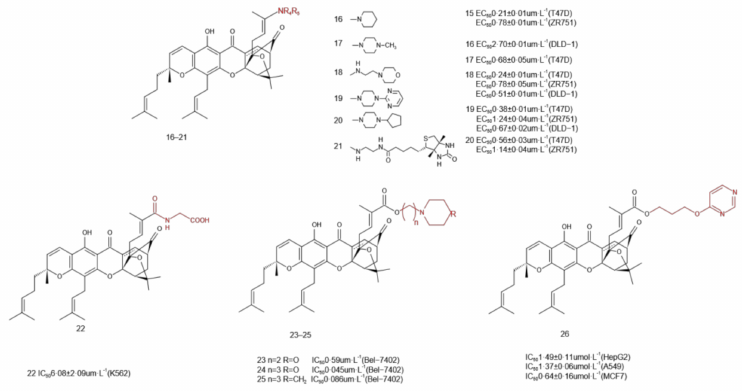
Figure 6. C-30 structure